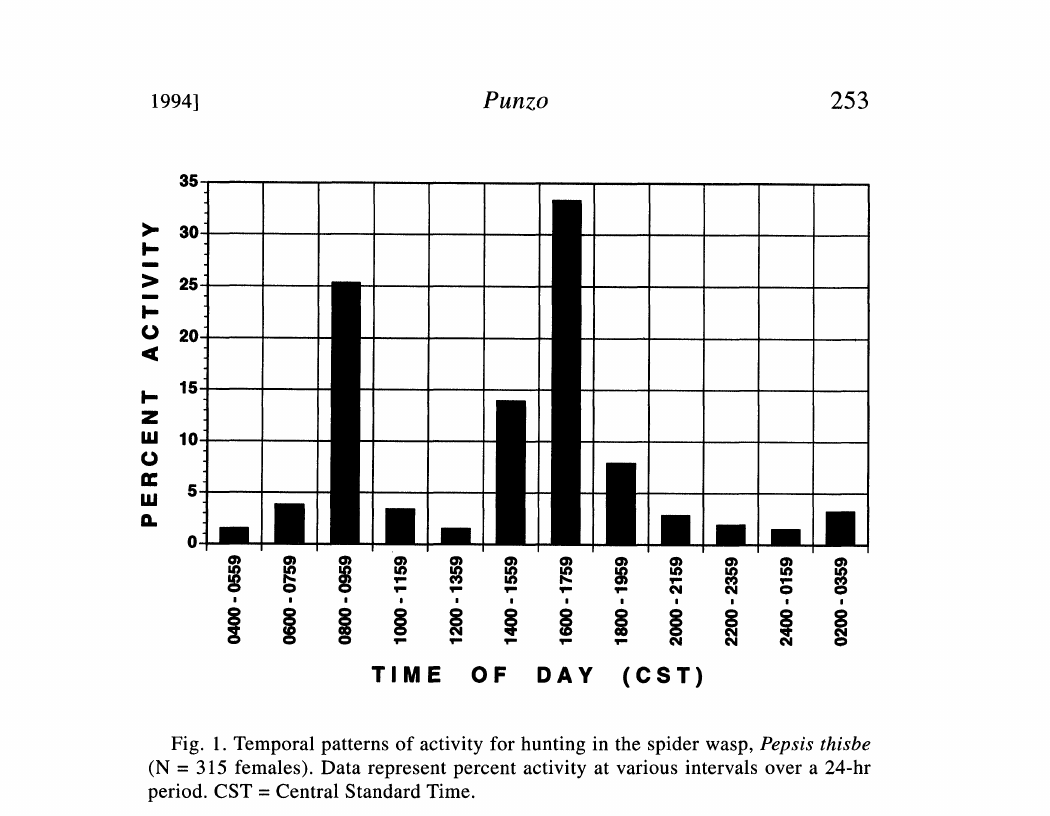
Fig. 1. Temporal patterns of activity for hunting in the spider wasp, Pepsis thisbe (N 315 females). Data represent percent activity at various intervals over a 24-hr period. CST Central Standard